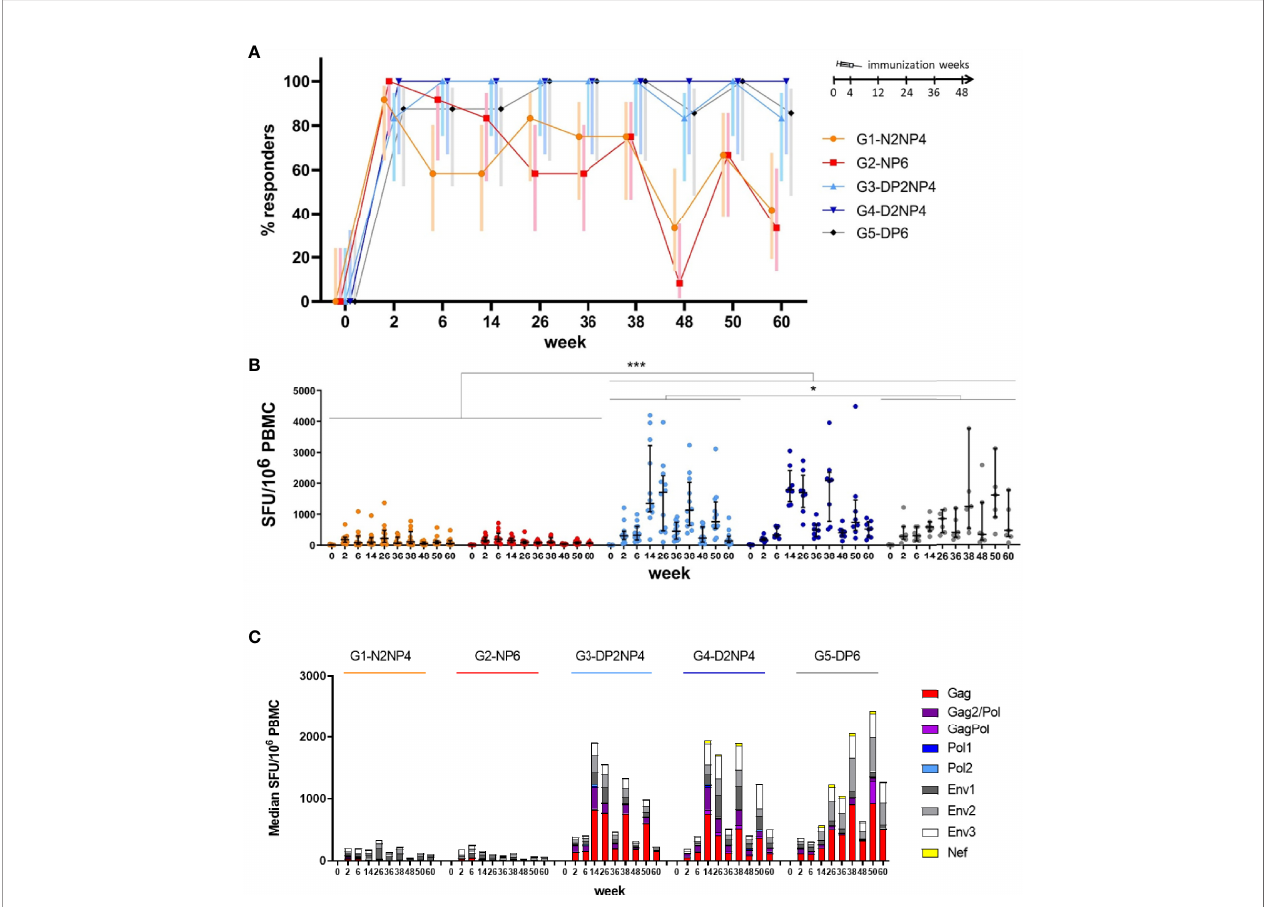
FIGURE 2 | HIV-1-speci fi c IFN- g -producing cells along the study by ELISpot assay. (A) Percentage of responders by group and week with 95% con fi dence interval (CI). Criteria for responders were de fi ned as 50 spot-forming units (SFUs) per million PBMCs and at least 4-fold increase above the baseline level for total HIV-1 response (sum of the nine different HIV-1 peptide pools). (B) Magnitude of the total HIV-1 response by group and week. PBMCs were freshly isolated at the indicated time-points, restimulated ex vivo with the nine different HIV-1 peptide pools and the number of HIV-1-speci fi c IFN- g -producing cells was quanti fi ed as SFUs/10 6 PBMCs. Results are shown per animal (sum of the responses from the nine peptide pools) as colored dots, along with the median and interquartile range per group in black. Statistical signi fi cance was determined using Tukey´s multiple comparisons test. *, p < 0.05; ***, p < 0.001. (C) Magnitude of the total HIV-1 response by antigen, group and week. Absolute data from panel B are shown as median responses of each group towards the 9 peptide pools